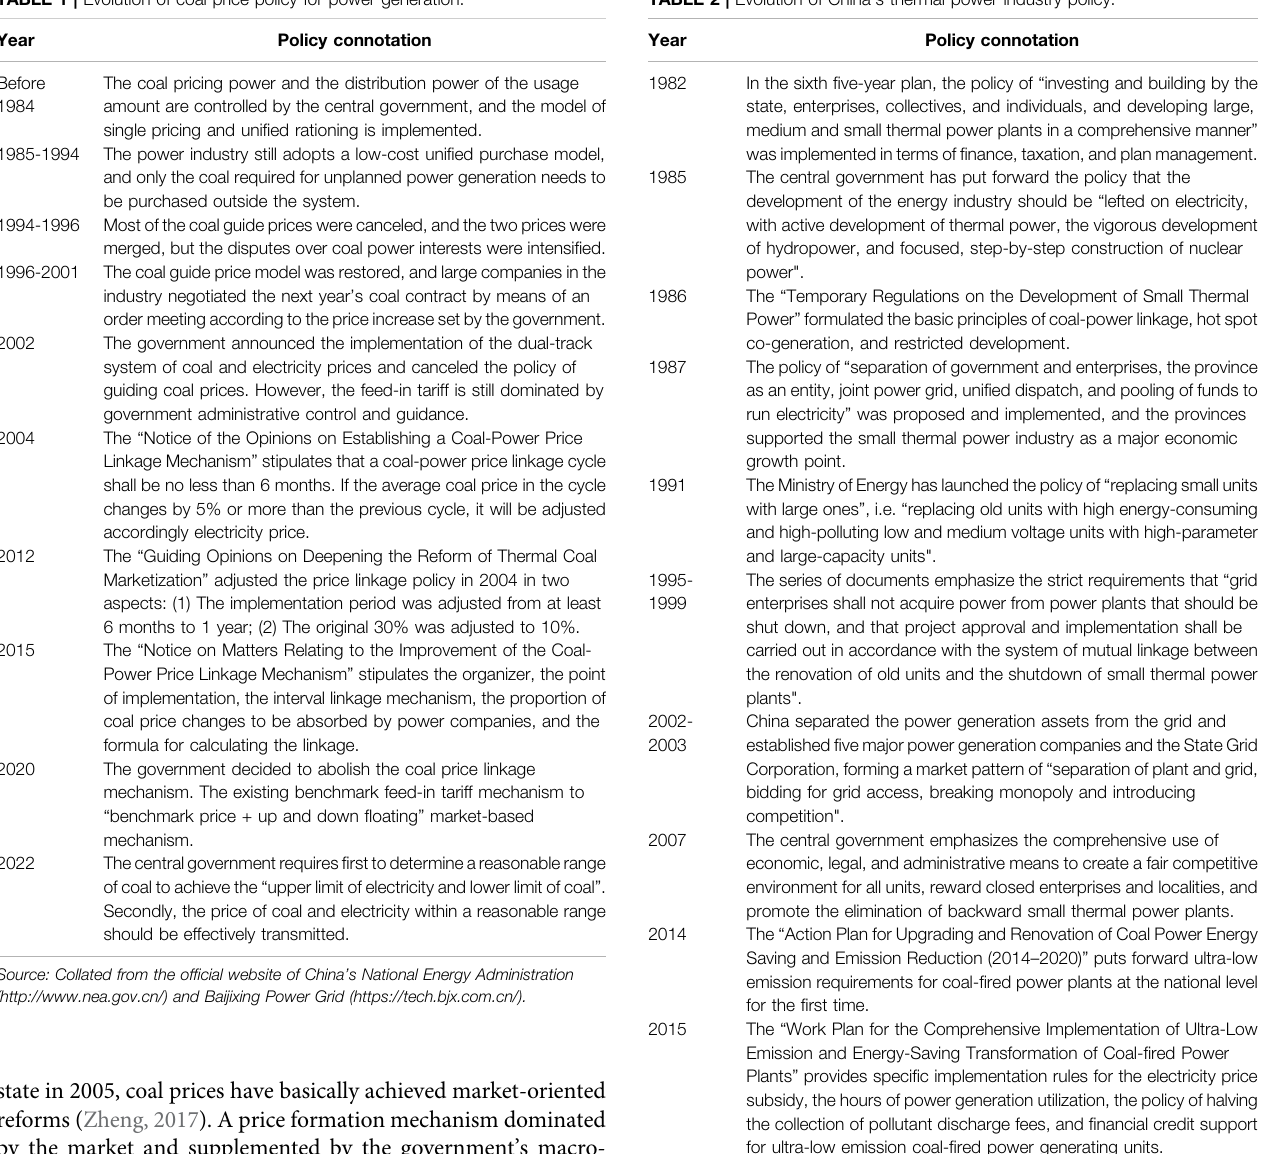
TABLE 1 | Evolution of coal price policy for power generation. TABLE 2 | Evolution of China ’ s thermal power industry